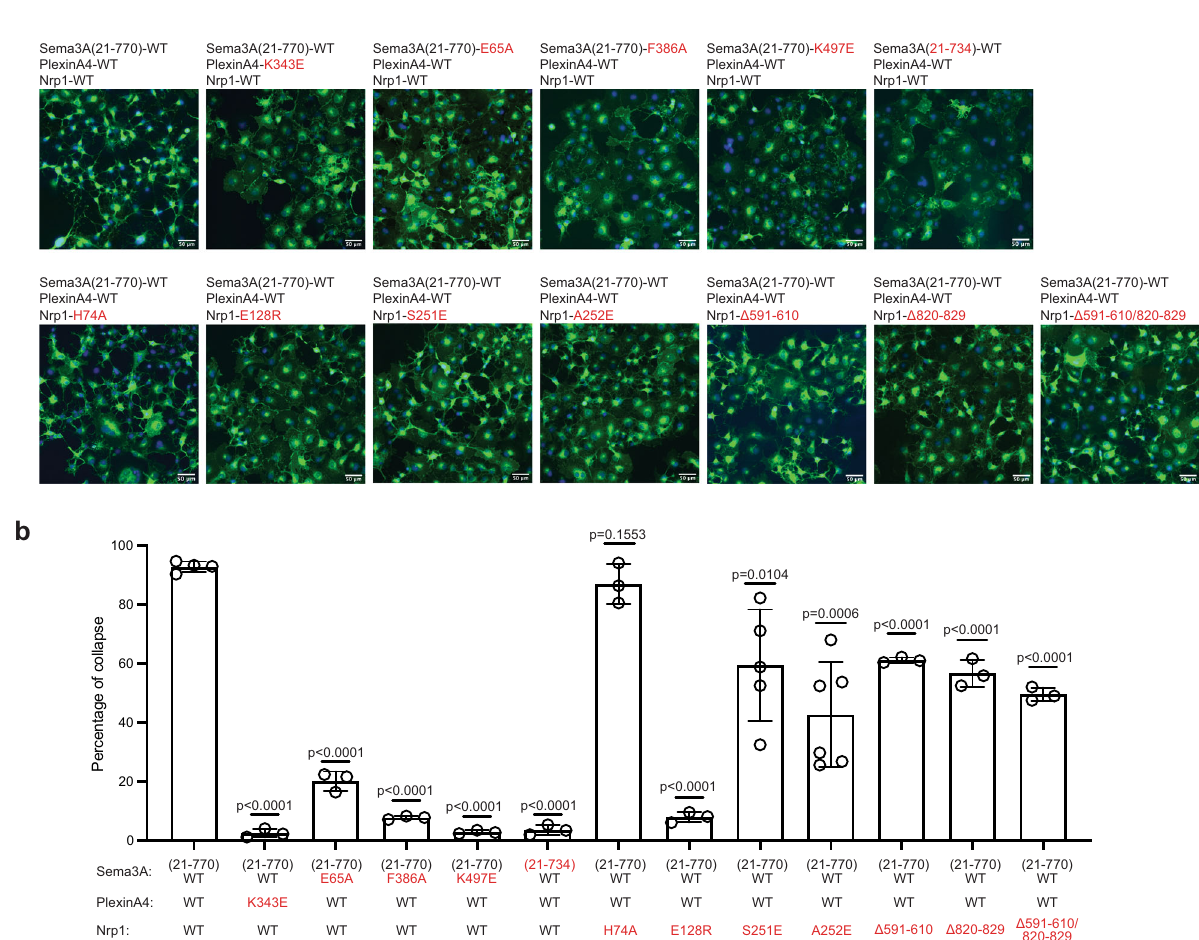
Fig. 5 COS7 cell collapse assays for mutants of Sema3A, PlexinA4, and Nrp1. a Images of COS7 cell collapse. Cells stably expressing various combinations of PlexinA4 and Nrp1 constructs were treated with different Sema3A constructs at 5 nM for 30 min. Cells are visualized by immuno-staining for myc-tagged PlexinA4 (green). Nuclei are stained with DAPI (blue). One representative image from at least three biological repeats is shown for each group. b Quanti fi cation of cell collapse. The individual data points, mean, and s.e.m of the percentage of cell collapse from at least three biological repeats are shown ( n = 4 for Sema3A-WT/PlexinA4-WT/Nrp1-WT, n = 5 for Sema3A-WT/PlexinA4-WT/Nrp1-S251E, n = 6 for Sema3A-WT/PlexinA4-WT/ Nrp1-A252E, n = 3 for other groups). Statistical signi fi cance p -values between wild-type and each mutant group were determined by two-tailed Student ’ s t - test and shown on the top of the bars. Scale bar, 50 µ